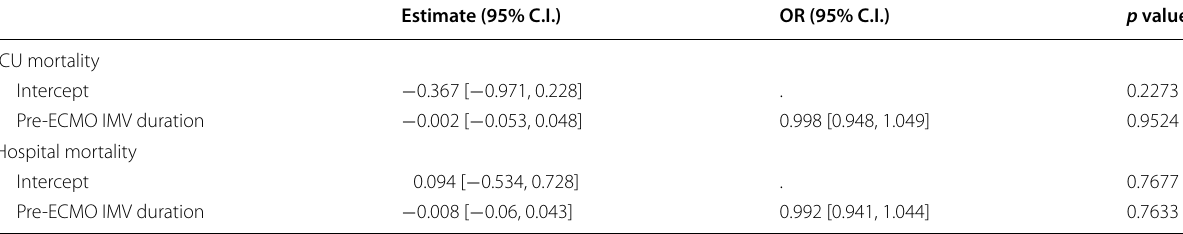
IMV invasive mechanical ventilation, ECMO extracorporeal membrane oxygenation, ICU intensive care